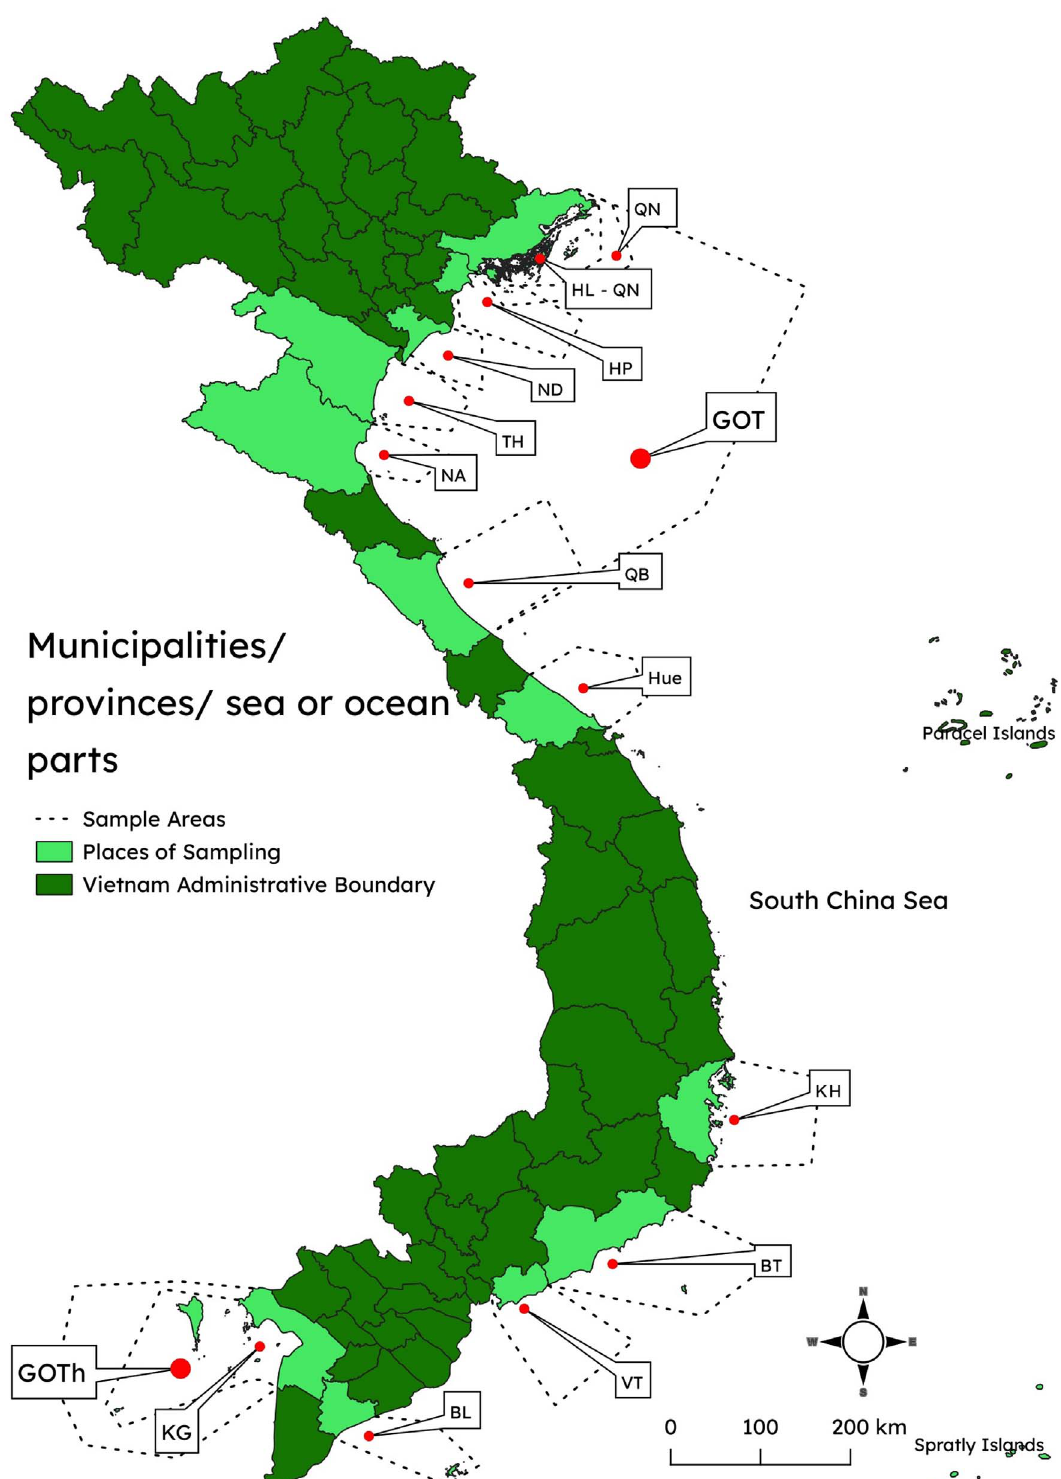
Figure 1. A map of Vietnam with abbreviated names of municipalities, provinces, and sea or ocean areas where samples were